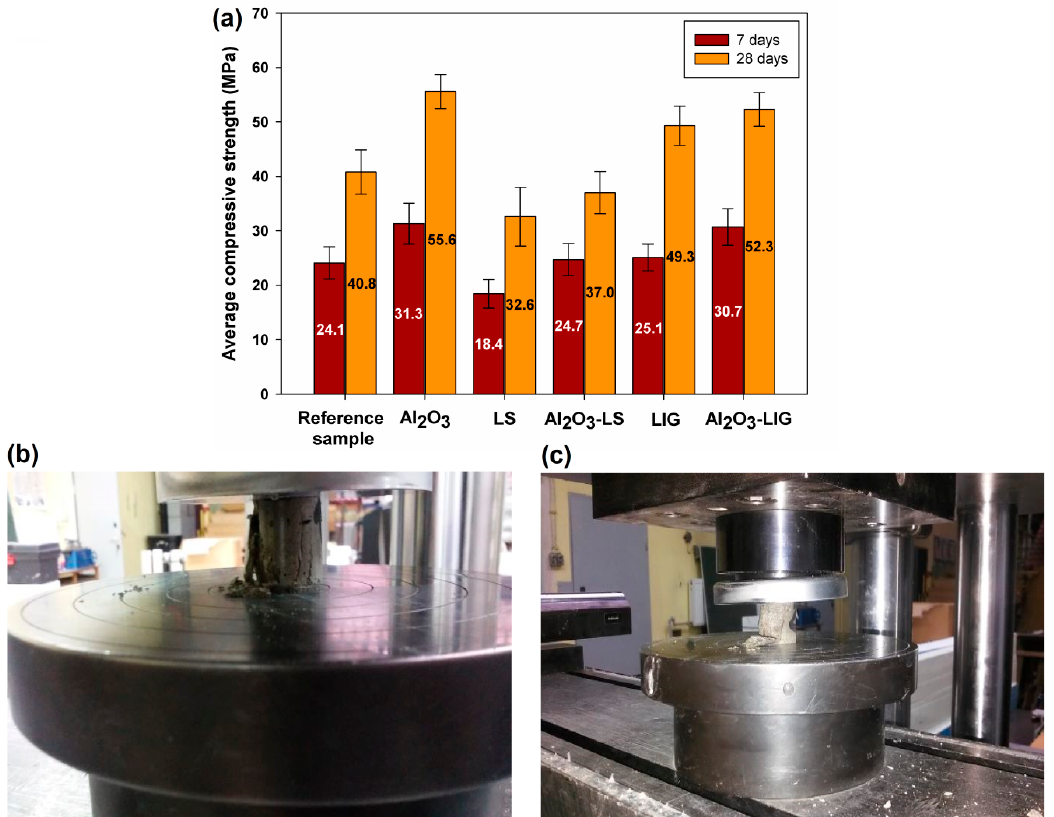
Figure 6. Compressive strength test results for samples containing 0.5 wt.% admixture after 7 and 28 days ( a ) and photos obtained during compressive strength tests for alumina-lignosulfonate ( b ) and alumina-lignin ( c ) hybrid materials.